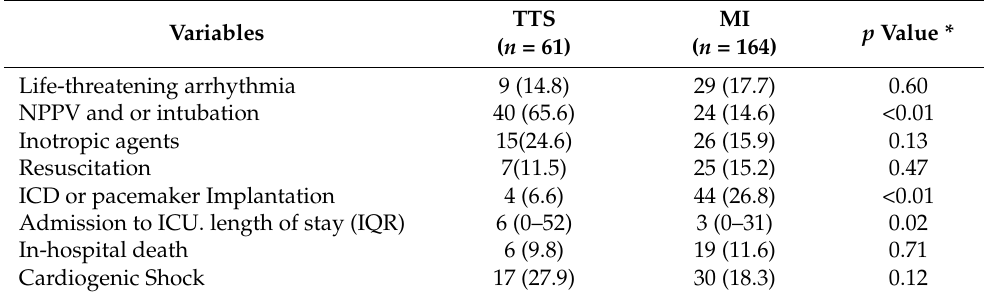
Table 2. In-hospital events and treatment strategies in patients suffering from takotsubo cardiomyopathy (TTS) and KF compared to patients with myocardial infarction and kidney failure. TTS Variables